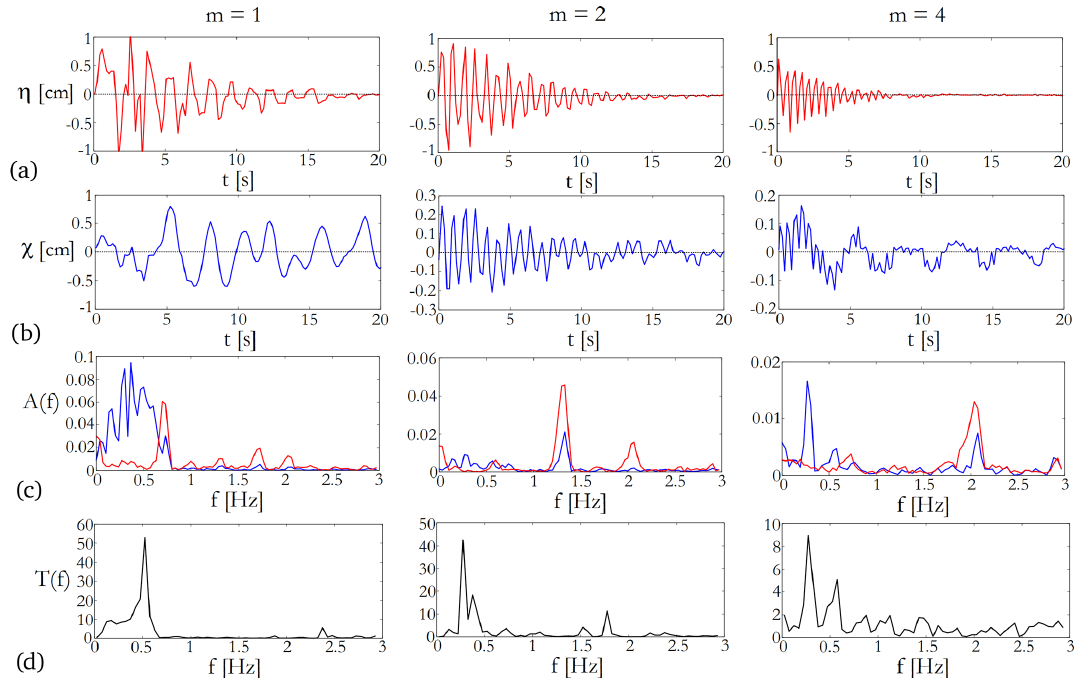
Figure 5. Time series and spectra from three exemplary runs (configuration #1, cf. Table 2) of dominant modes m = 1, m = 2, and m = 4 from the left. The panels of row (a) show the water surface displacement as a function of time t from the initiation as tracked in the close vicinity of the sidewall. The displacement of the pycnocline χ at the sidewall is presented in row (b) (note that here, unlike in the η(t) plots, the vertical range is different in all three panels). The Fourier spectra of the η(t) (red) and χ(t) (blue) records are visible in row (c) , whereas the panels in (d) show the transfer function T (f ) = A χ (f )/A η (f ) , i.e., the ratio of the spectra of the corresponding two spectra above.